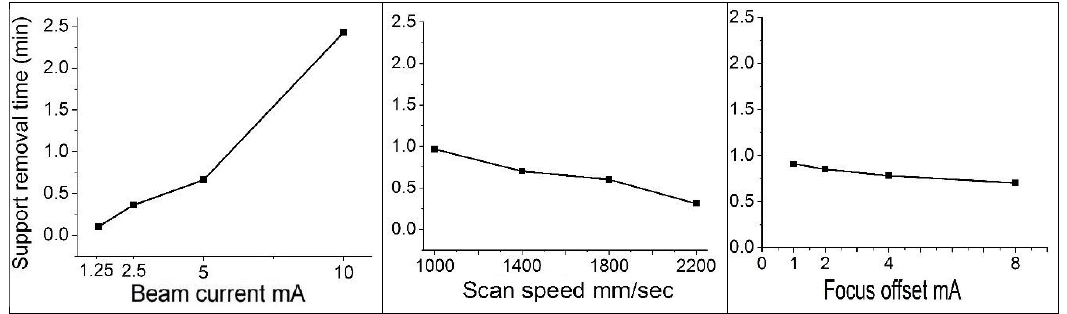
Figure 10. Effect of EBM process parameters on support removability. Figure 10. E ff ect of EBM process parameters on support removability.